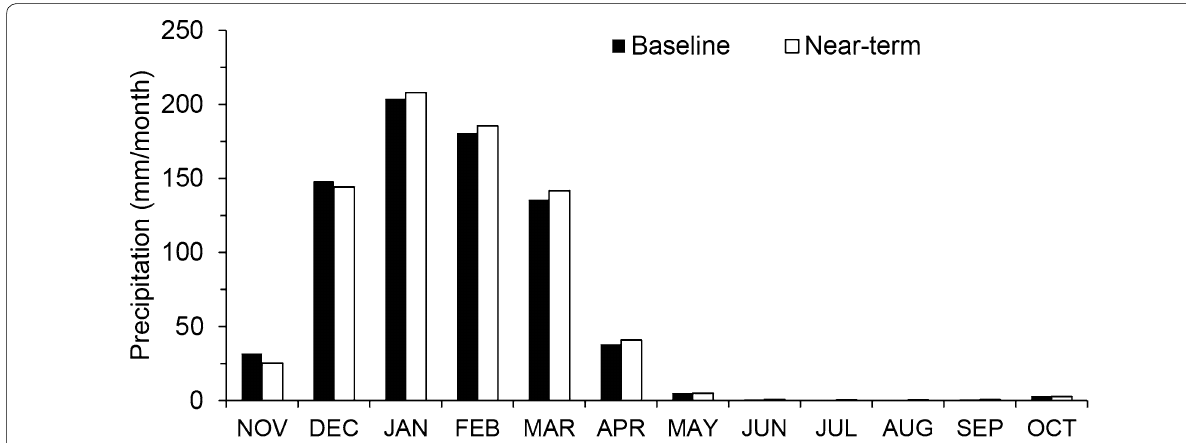
Fig. 16 Monthly total precipitation of Ndembera watershed averaged over the whole baseline and near-term periods